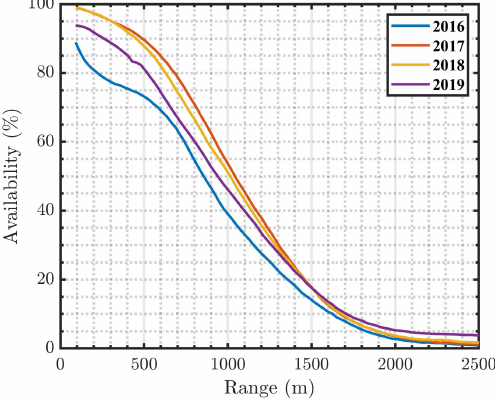
Figure A2. ARM SGP C1 Doppler lidar wind speed profile range availability versus range using processed VAD scans from 2016 to 2019 after SNR filtering (threshold of